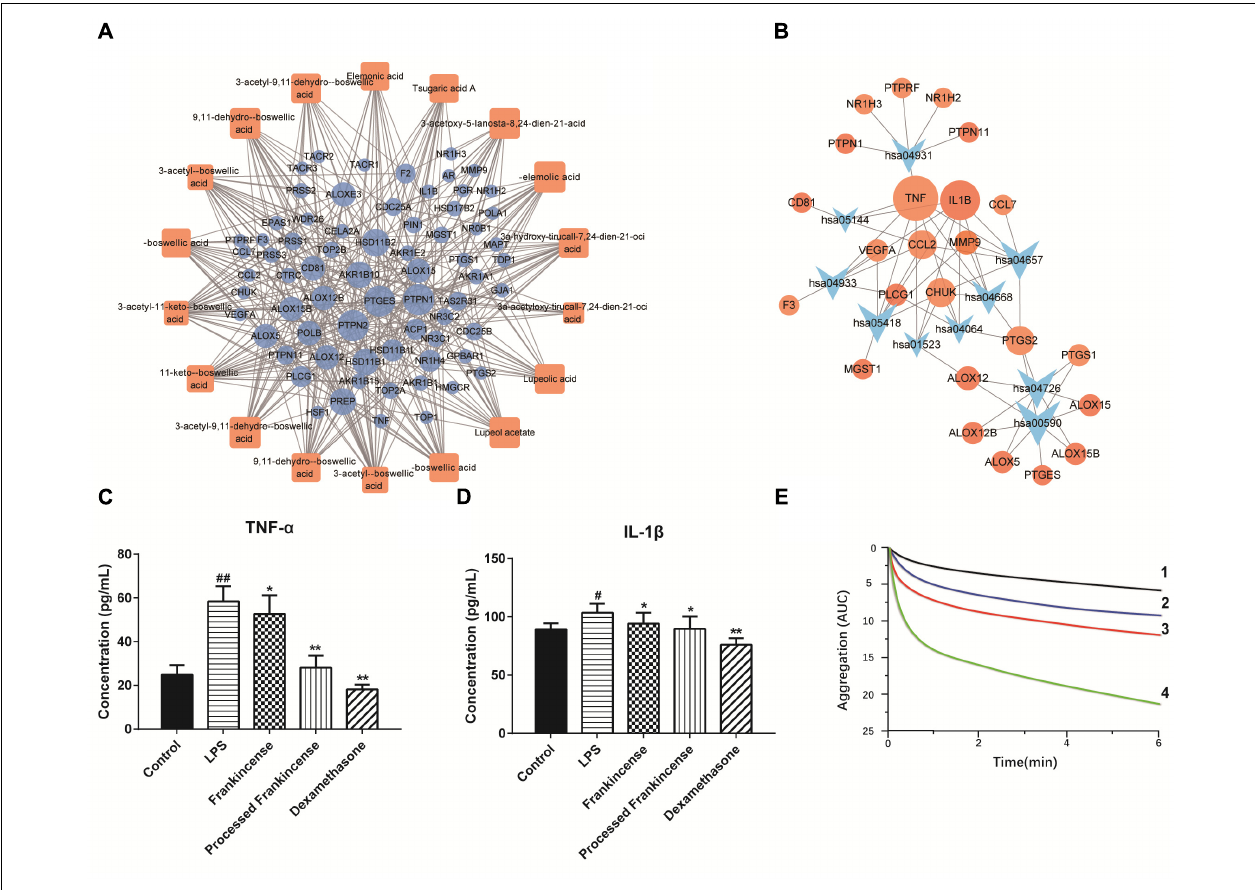
FIGURE 4 | Pharmacological prediction and validation of frankincense and processed frankincense. (A) Potential biomarker-target network of frankincense and processed frankincense. (B) Target-pathway of potential biomarkers of frankincense and processed frankincense. (C) Effects of frankincense and processed frankincense on TNF- α . (D) Effects of frankincense and processed frankincense on IL-1 β . (E) Effects of frankincense and processed frankincense on antiplatelet effects induced by AA (1. Aspirin group; 2. Processed frankincense group; 3. Frankincense group; 4. Control group). ( ## P < 0.01, comparison with the control group; ∗ and ∗∗ P < 0.05 and 0.01, comparison with the LPS